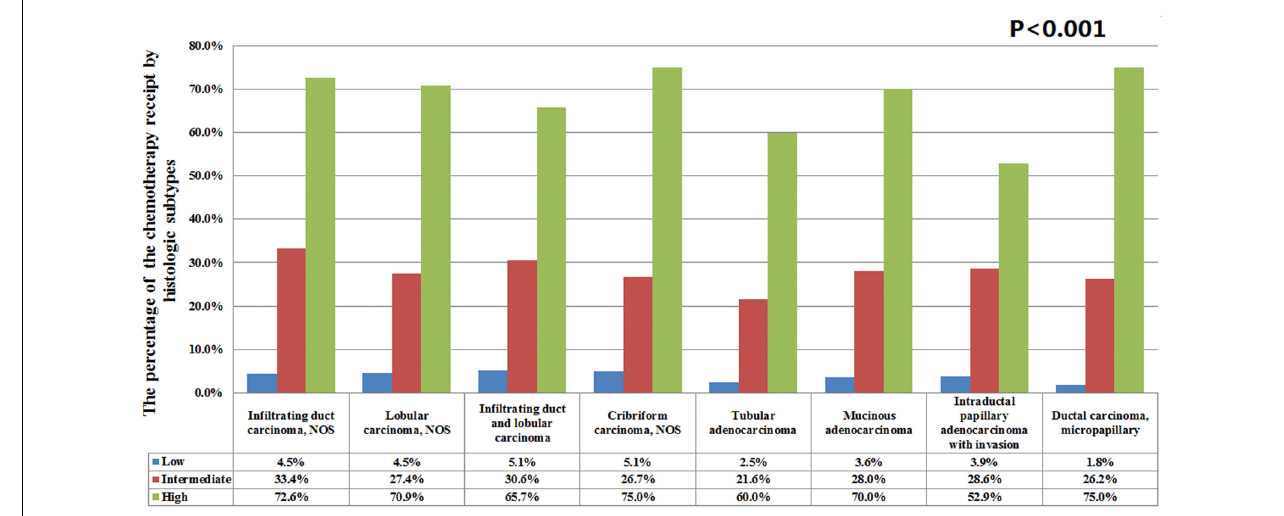
FIGURE 2 | The percentage of chemotherapy administration among histologic subtypes of breast cancer.